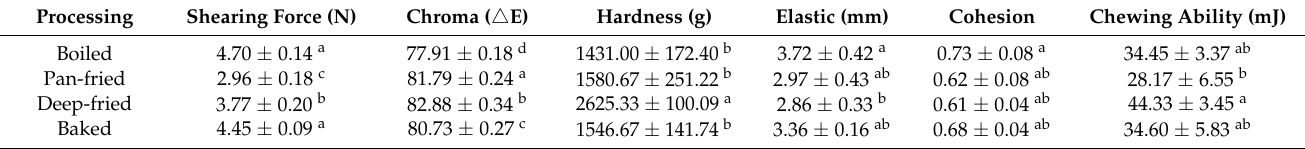
Table 2. Edible quality indicators of differently processed BTS